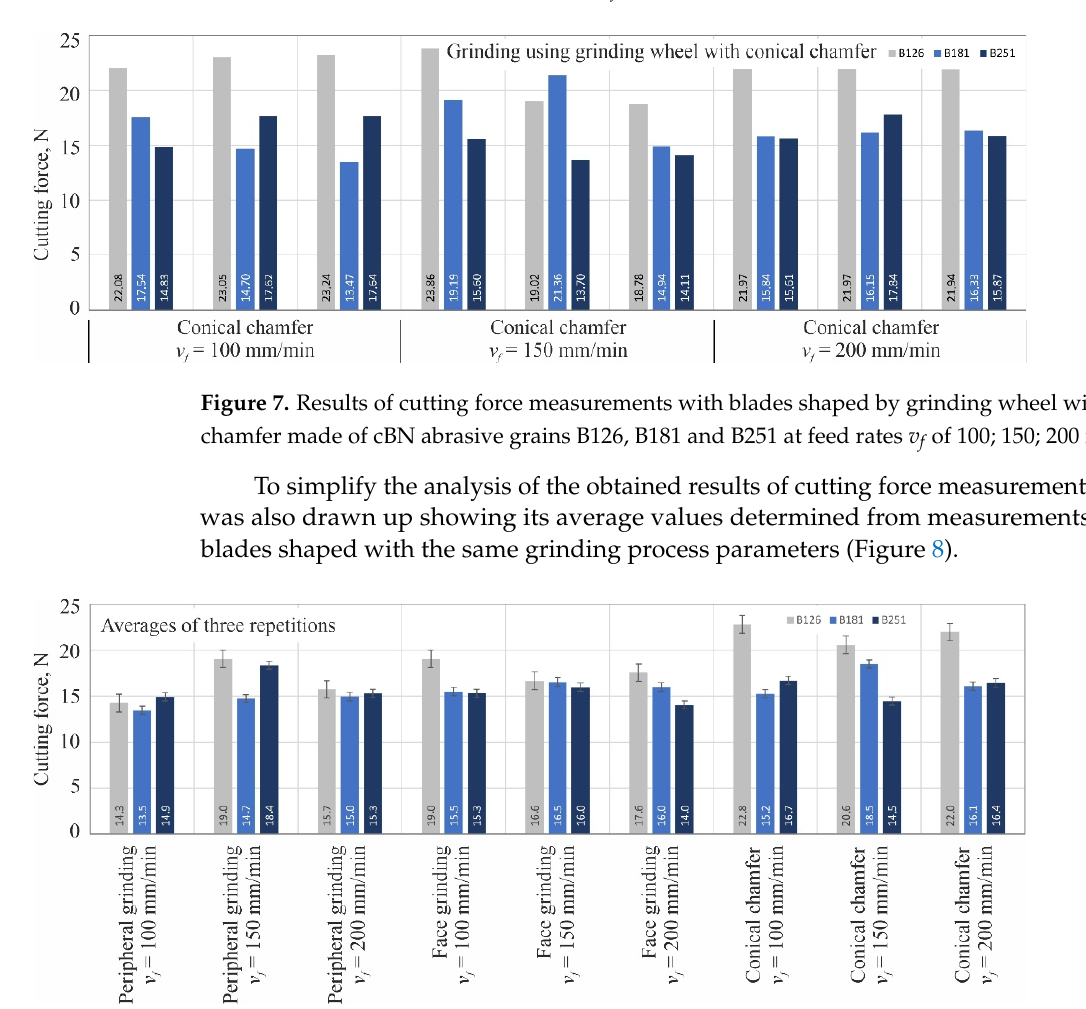
Figure 6. Results of cutting force measurements of blades shaped by face grinding with cBN abrasive grains B126, B181 and B251 at feed rates v f of 100; 150; 200 mm/min.